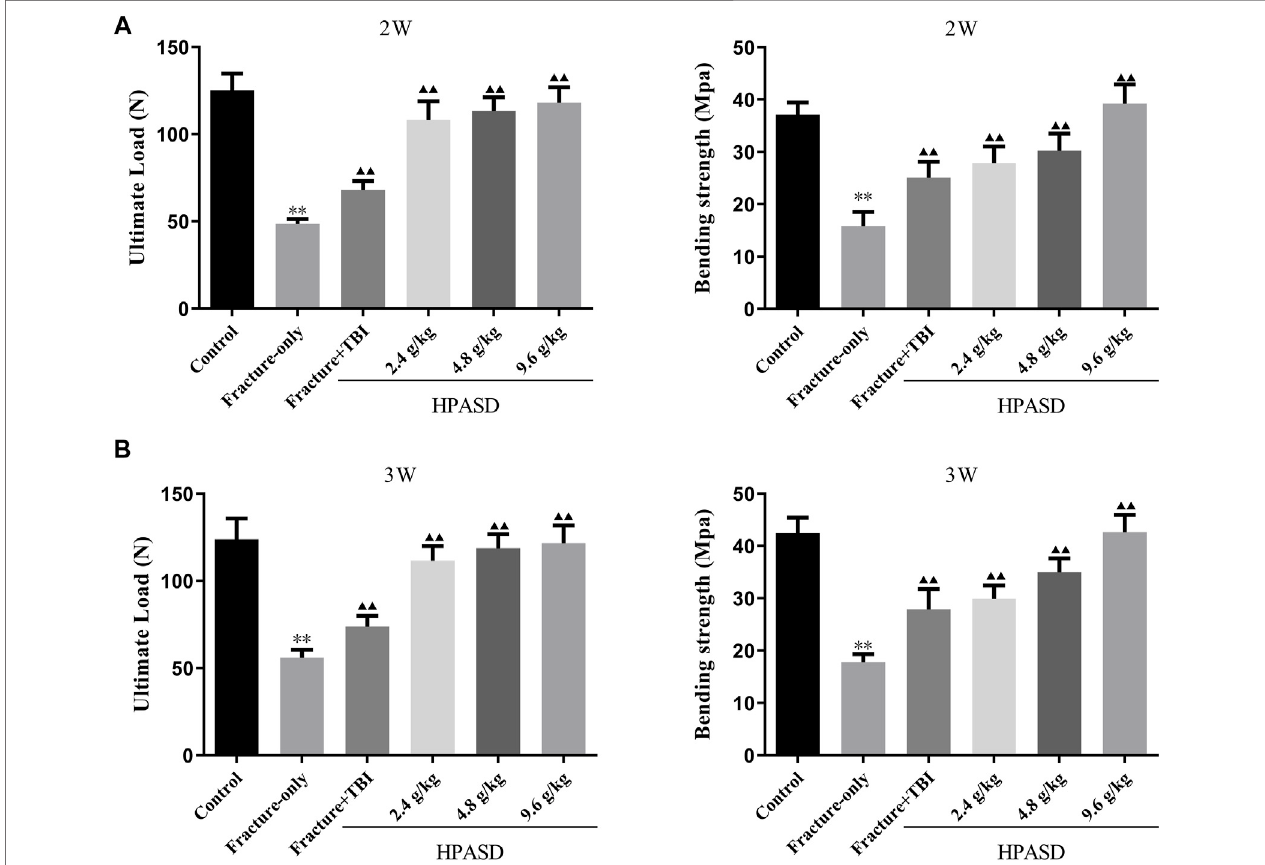
FIGURE6| HPASDpreservedbonestrengthinthetibiaofTBIrats.Theresultsofthethree-pointbendingexaminationof (A) ultimateloadand (B) bendingstrength in the tibia of TBI rats with HPASD treatment. * p < 0.05 , ** p < 0.01 vs. Fracture-only group; ▲ p < 0.05 , ▲▲ p < 0.01 vs. Fracture + TBI group [unpaired Student ’ s t-test].